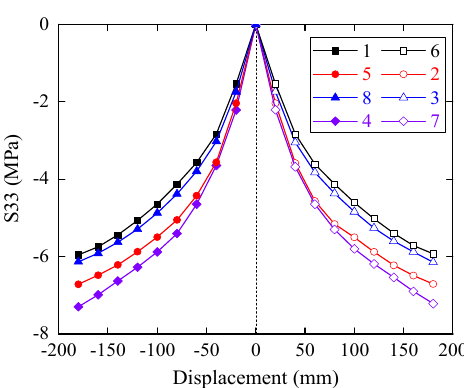
Figure 13. S33 of points 2 and 3.